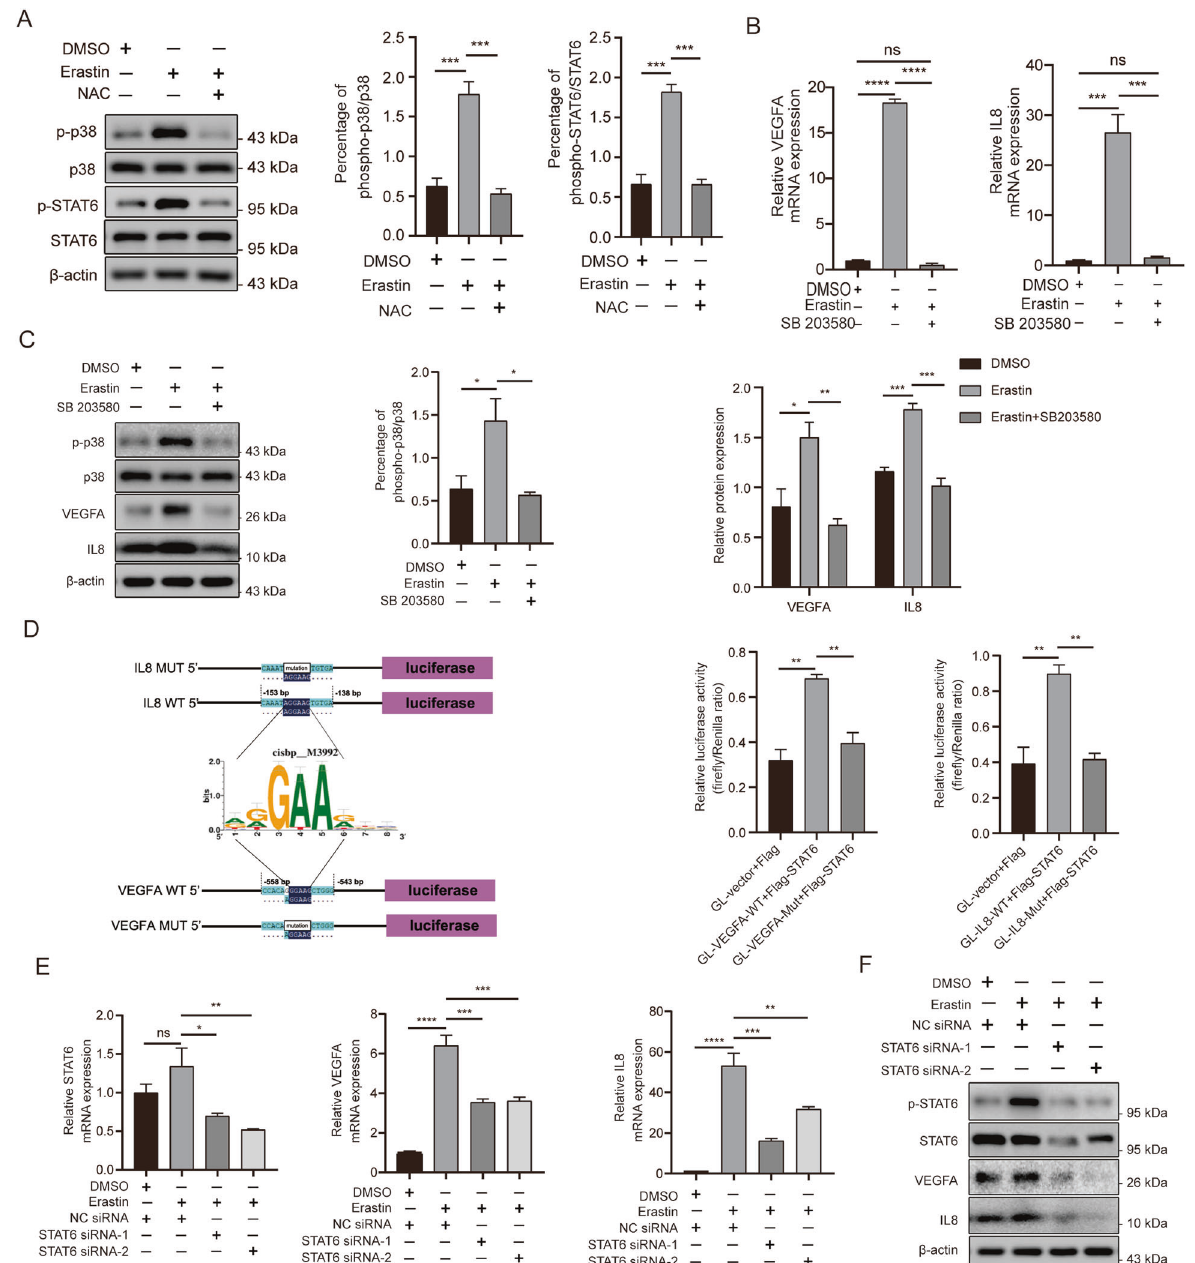
Fig. 4 p38 MAPK/STAT6 pathway is involved in ferroptosis-induced VEGFA and IL8 upregulation. A ESCs were incubated with erastin and NAC, and the activation of p38 and STAT6 was examined using western blot. B , C The p38 inhibitor SB203580 (10 µM) was added to erastin- treated ESCs and the activation of p38 was measured using western blot. VEGFA and IL8 expression and secretion were measured using RT- qPCR, western blot ( n = 3). D The prediction model of enriched motifs for DNA-binding activators of STAT6 bind both the TSSs of VEGFA and CXCL8 and is validated using luciferase reporter assays. E , F ESCs were transfected with STAT6 siRNAs for 48 h and then incubated with erastin for 12 h. The transfection ef fi ciency and expression of VEGFA and IL8 were detected using RT-qPCR and western blot ( n = 3). Comparisons were made using one-way ANOVA ( A – F ). * P < 0.05, ** P < 0.01, *** P < 0.001, **** P < 0.0001. ns not statistically signi fi cant, p38 MAPK/STAT6 p38 mitogen-activated protein kinase/signal transducer and activator of transcription 6, ESCs endometrial stromal cells, VEGFA